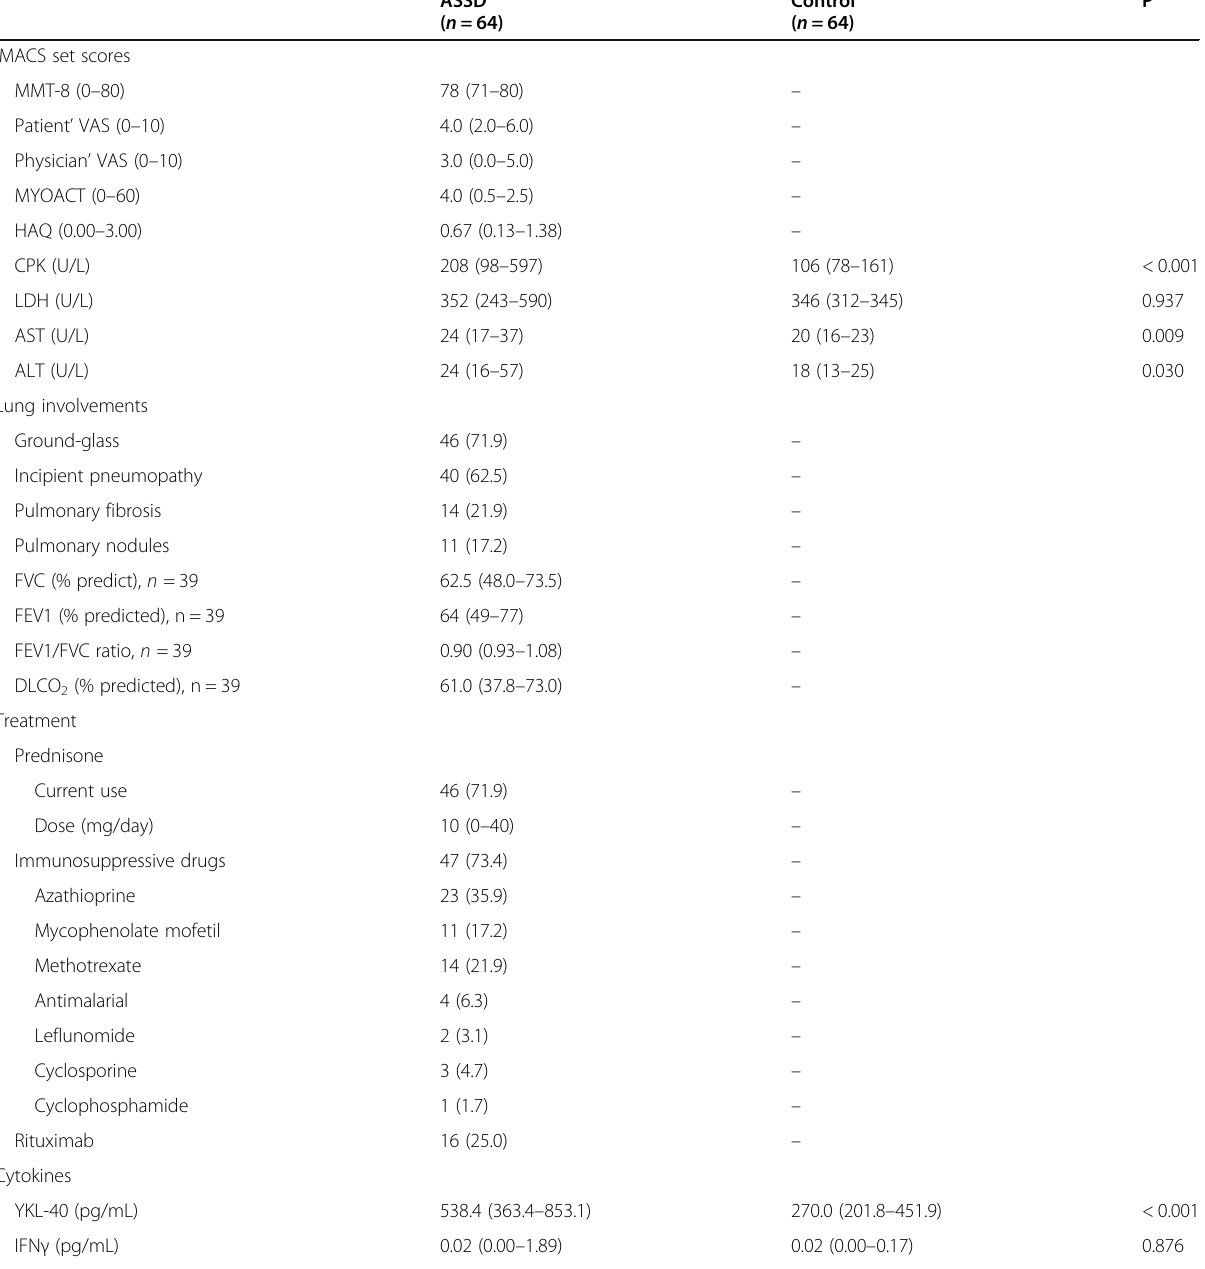
Table 2 Demographic, current disease status, pulmonary involvement, treatment, and the cytokines serum levels of the patients with antisynthetase syndrome. Laboratory profiles of the control group